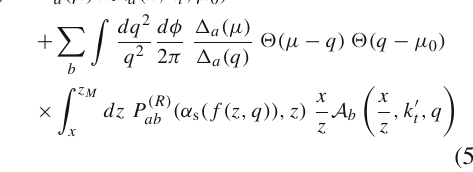
momenta of the initial state partons, the transverse momenta are limited by a theta function at the factorization scale, while off-shell matrix elements give a smooth transition to a high k t